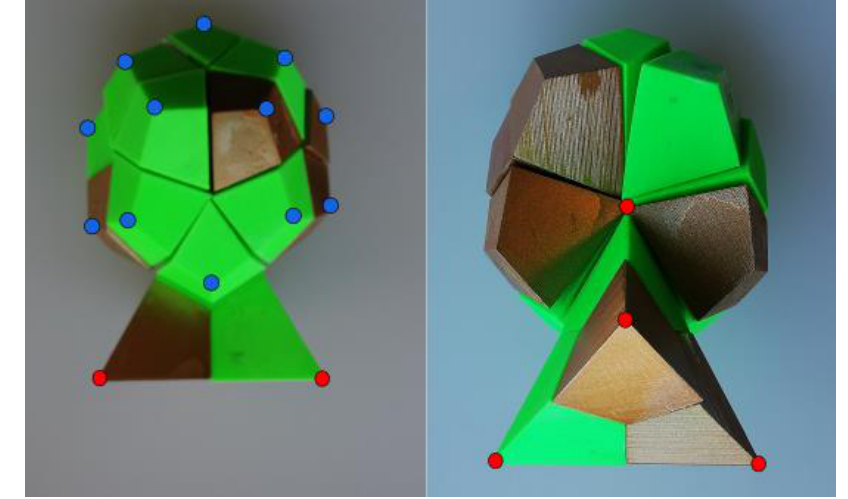
Figure 2. Volume of the dual space obtained as a union of portions of the tetrahedron of the primal mesh by barycentric division. Nodes of the dual mesh – blue colour – and nodes of the primal mesh – red colour.